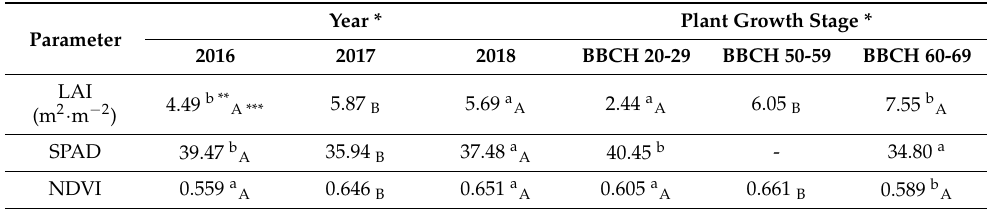
Table 5. Parameters of common buckwheat by year and growth